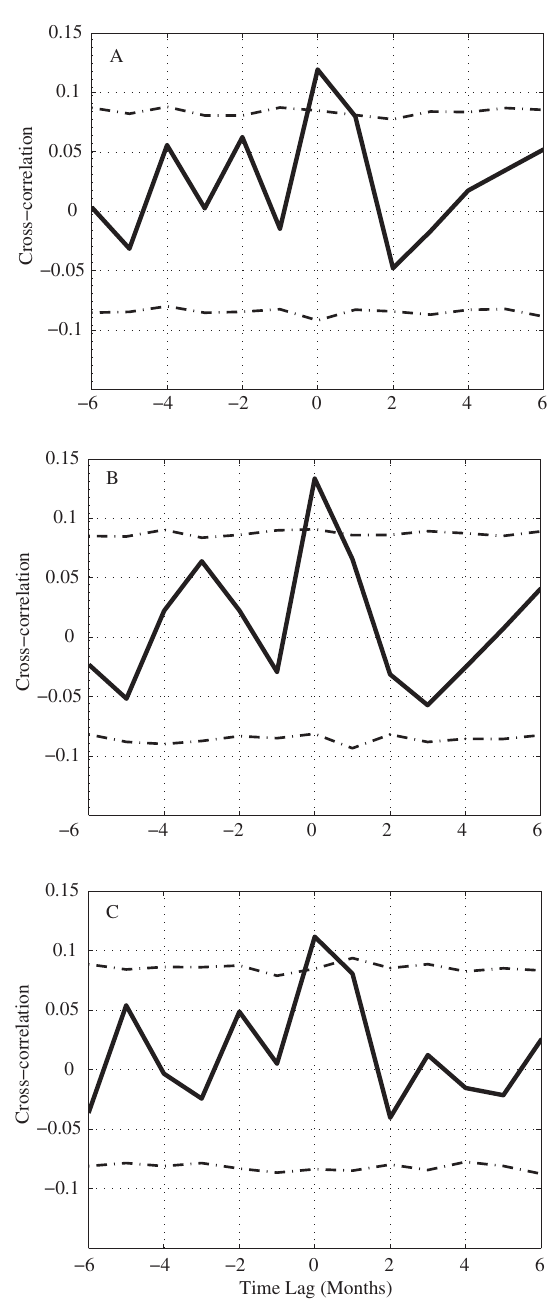
Fig . 9. – (a-top) Cross-correlation between second, third and fourth spatial variance eof mode time amplitudes and the monthly nao index time series. significant positive correlation found at time lag τ = 0. Confidence bounds at 95% obtained through monte-Carlo